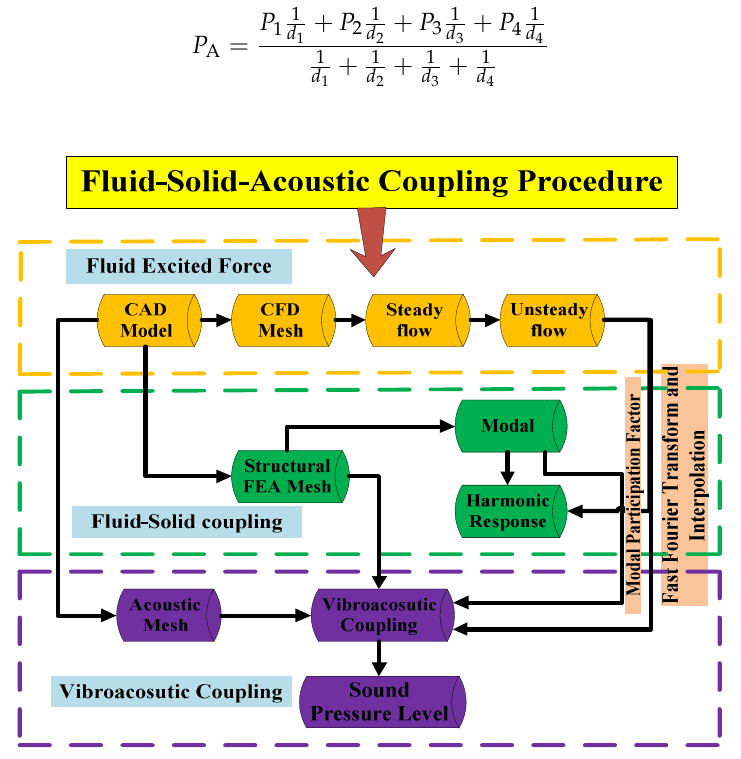
Figure 14. The flow chart of the numerical evaluation method of volute vibroacoustic coupling.